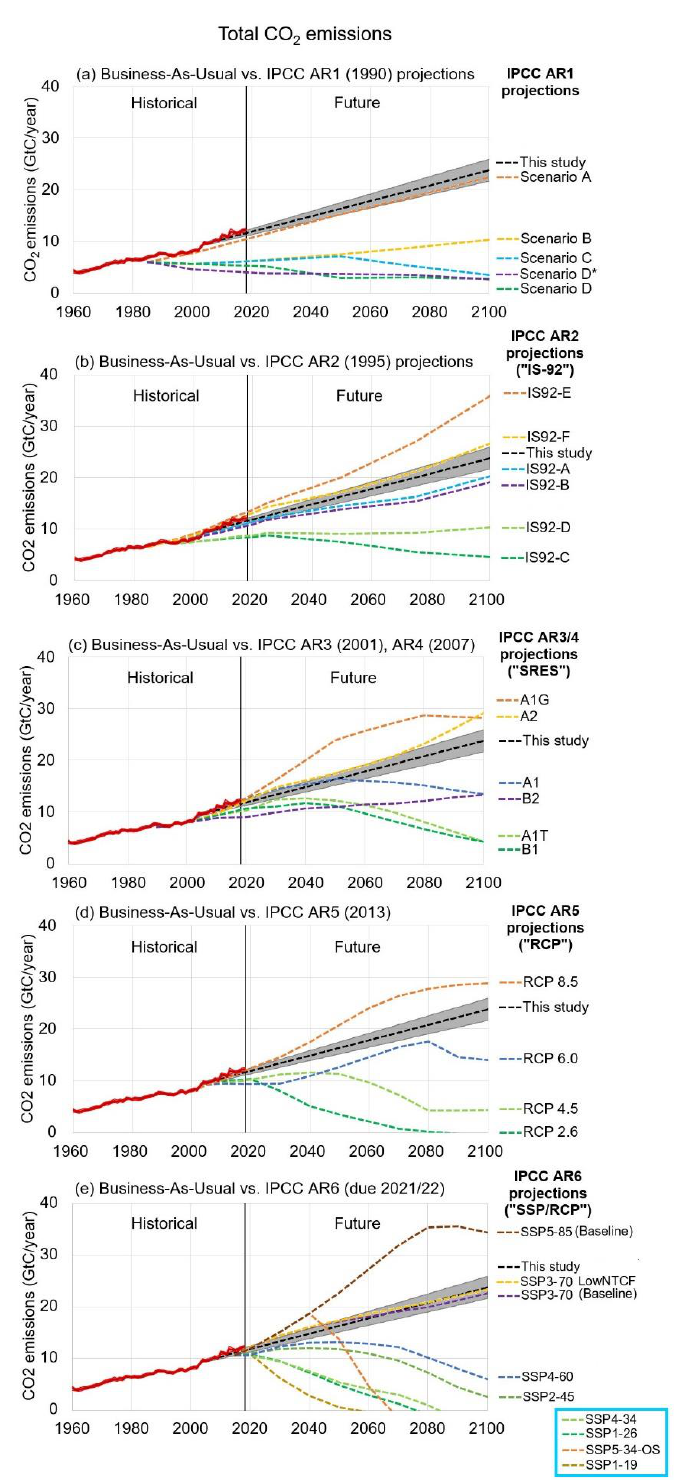
Figure 2. Comparison of the new “Business-As-Usual” projections of future total CO 2 emissions with the various projections considered by the IPCC’s ( a ) 1st Assessment Report (AR1, 1990); ( b ) the 2nd Assessment Report (AR2, 1995); ( c ) the 3rd Assessment Report (AR3, 2001); the 4th Assessment Report (AR4, 2007); ( d ) the 5th Assessment Report (AR5, 2013); and ( e ) the upcoming 6th Assessment Report (AR6, due c. 2021 / 2022). The horizontal axes correspond to years. Details on the projections are provided in Table